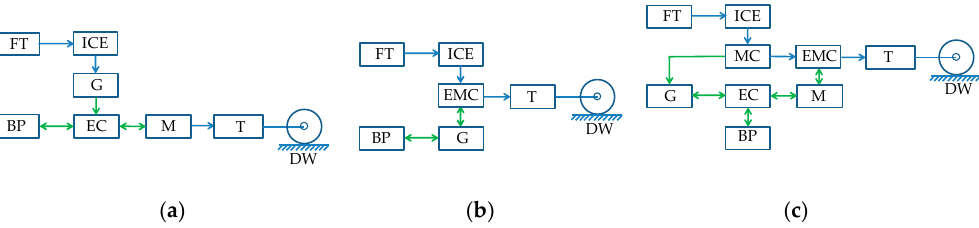
Figure 1. Three architectures of hybrid electric vehicles (HEVs): ( a ) series; ( b ) parallel; ( c ) power-split.